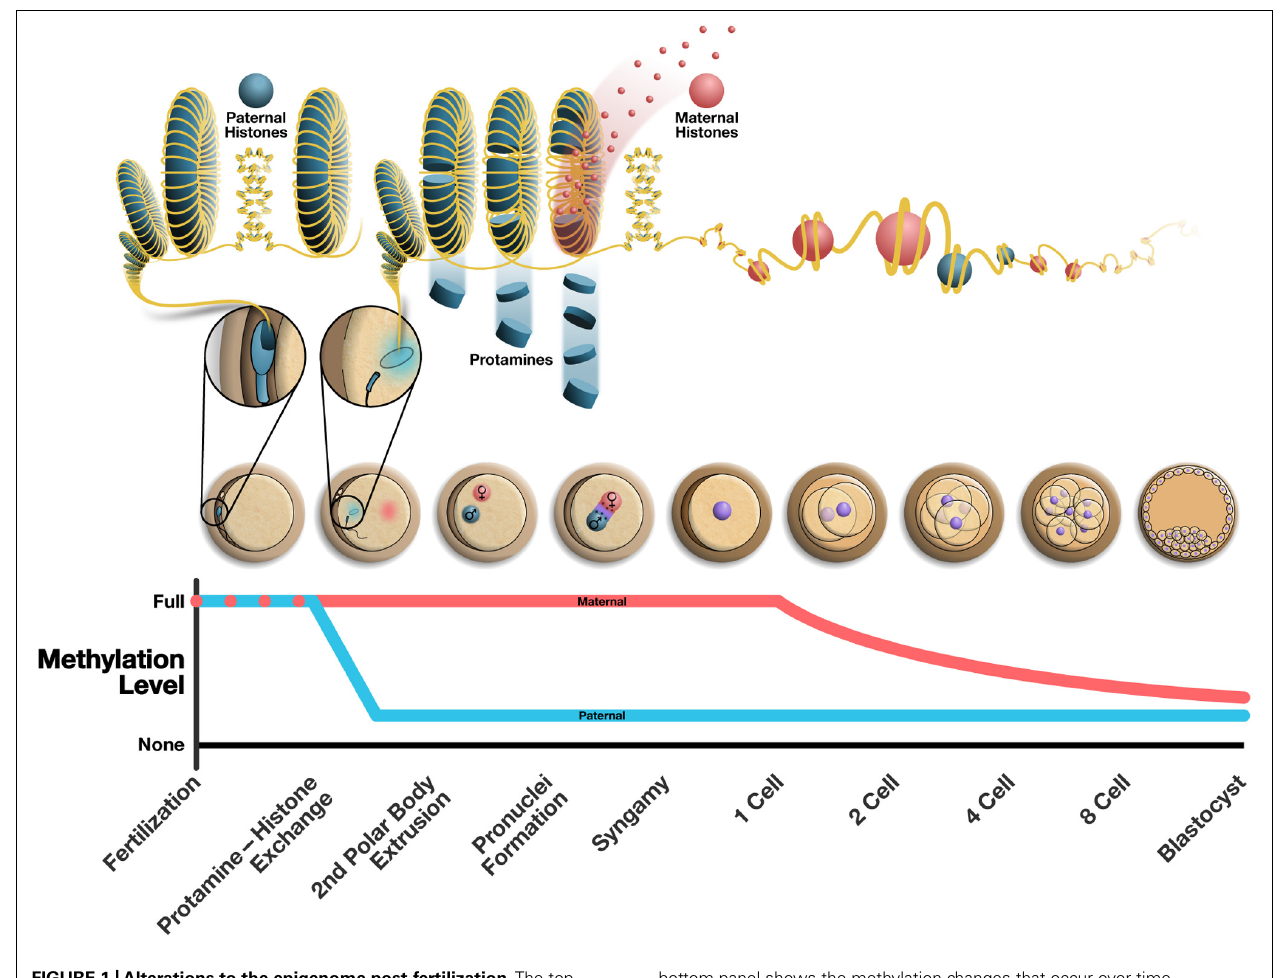
FIGURE 1 |Alterations to the epigenome post-fertilization. The top panel illustrates the chromatin structure of the mature sperm immediately following fertilization (highly protaminated with some retension of paternally derived histones). From the following cell is seen the protamine to histone transition where maternally derived histones replace protamines resulting in the decondensation of the sperm head.The middle panel illustrates the various stages of early embryonic development.The